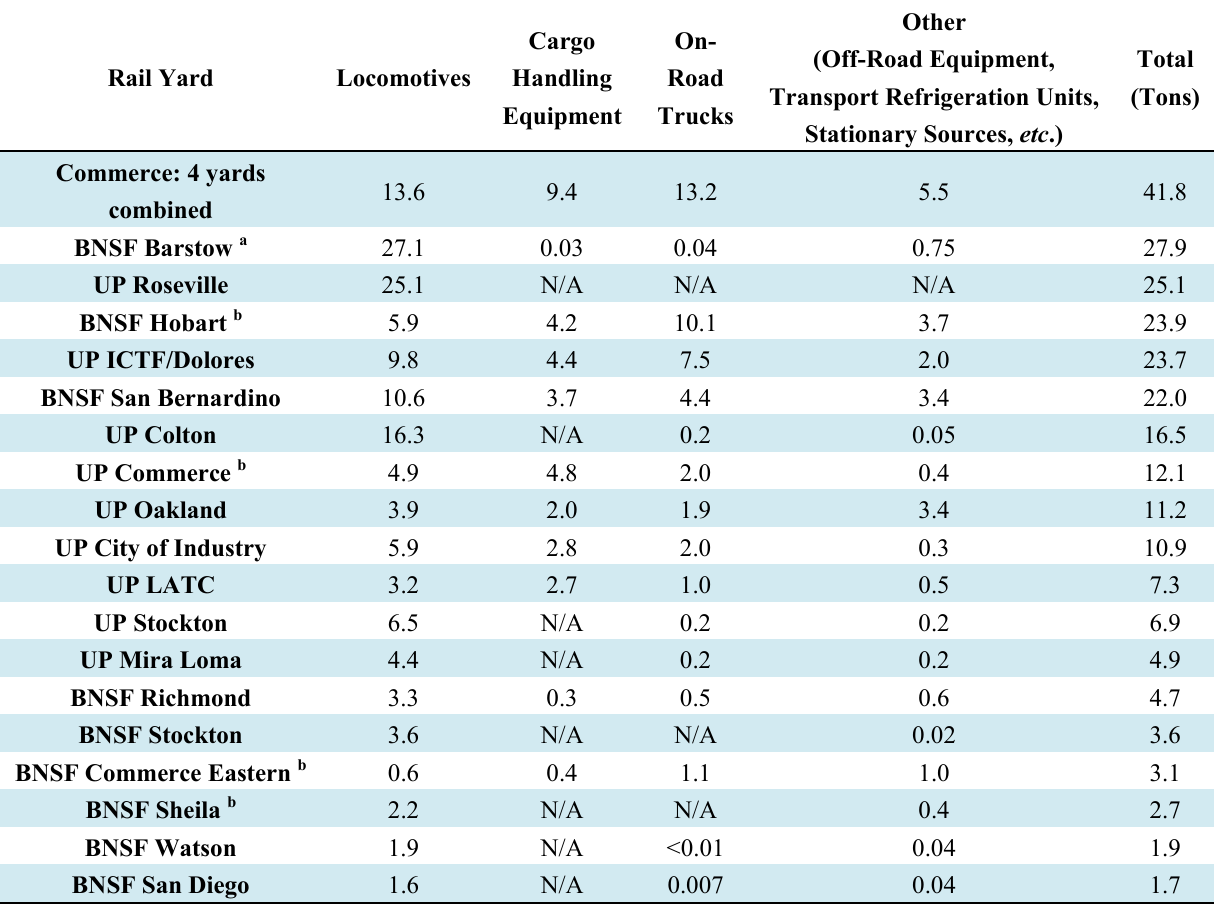
Table 1. Tons of annual diesel particulate matter emissions from the 18 rail yards in California by source of emissions, from Health Risk Assessments published by CARB during 2005–2008, listed in descending order by total emissions estimated in 2005 a